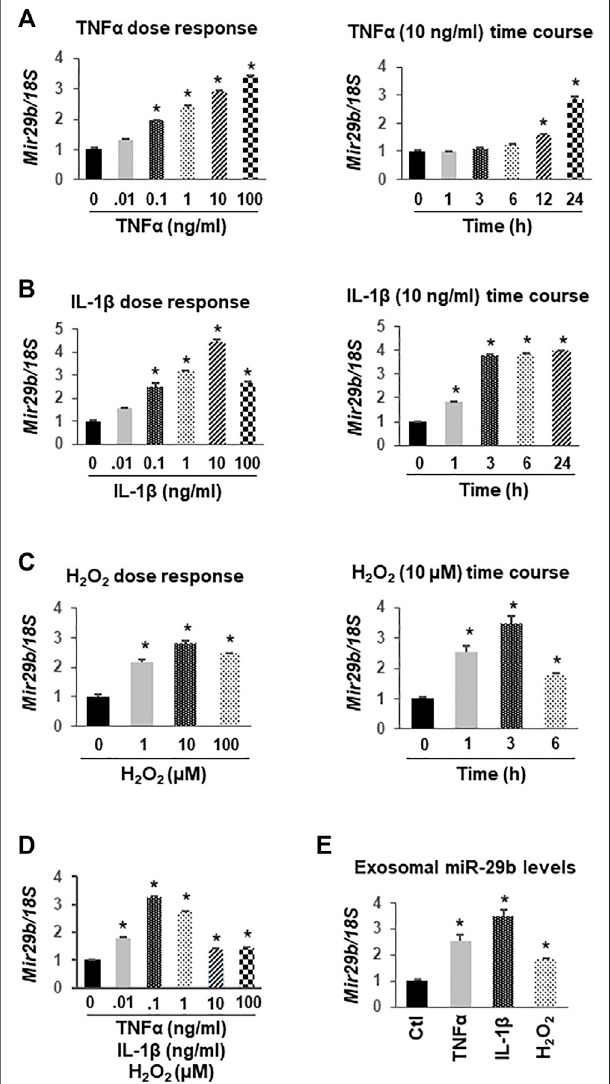
FIGURE5| UpregulationofmiR-29bgene( Mir29b )expressionbyTNF α , IL-1 β , and H 2 O 2 in CCD841 CoN colon epithelial cells. CCD841 CoN cells wereincubated withserialdosesofTNF α ,IL-1 β ,H 2 O 2 ortheircombinationfor 24 h, or with 10 ng/ml TNF α , 10 ng/ml IL-1 β , or 10 µM of H 2 O 2 for various times as indicated. Mir29b gene expression was quantitated by TaqMan-based RT-qPCR. (A) TNF α dose- and time-dependently elevated Mir29b levels. (B) IL-1 β increased Mir29b in a dose- and time-dependent manner. (C) H 2 O 2 dose- and time-dependently up-regulated Mir29b . (D) Combination of TNF α , IL-1 β , and H 2 O 2 augmented Mir29b expression. (E) Exosomal levels of Mir29b were elevated by 10 ng/ml TNF α , 10 ng/ml IL-1 β , or 10 µM H 2 O 2 after 24 h incubation. n = 3 independent experiments. * p < 0.01 vs. control (concentration or time